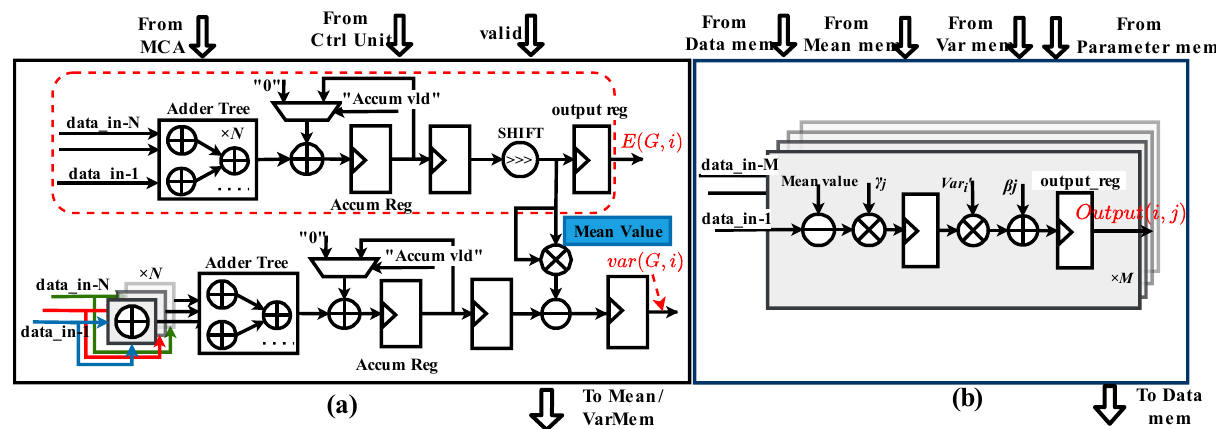
Figure 6. The detailed architecture of ( a ) mean value, variance computing modules, and ( b ) LNC. Figure 6b makes a hardware implementation of the Expression (2) using a pipeline approach to generate the final outcome of LN. The parallelism is designed as m , which matches the overall hardware architecture parameters. Except matrices data, the mean and variance need to be obtained from mem/var memory. The parameters γ j , β j also need to be stored in a parameter buffer in advance, and the final LN outputs are stored in output data